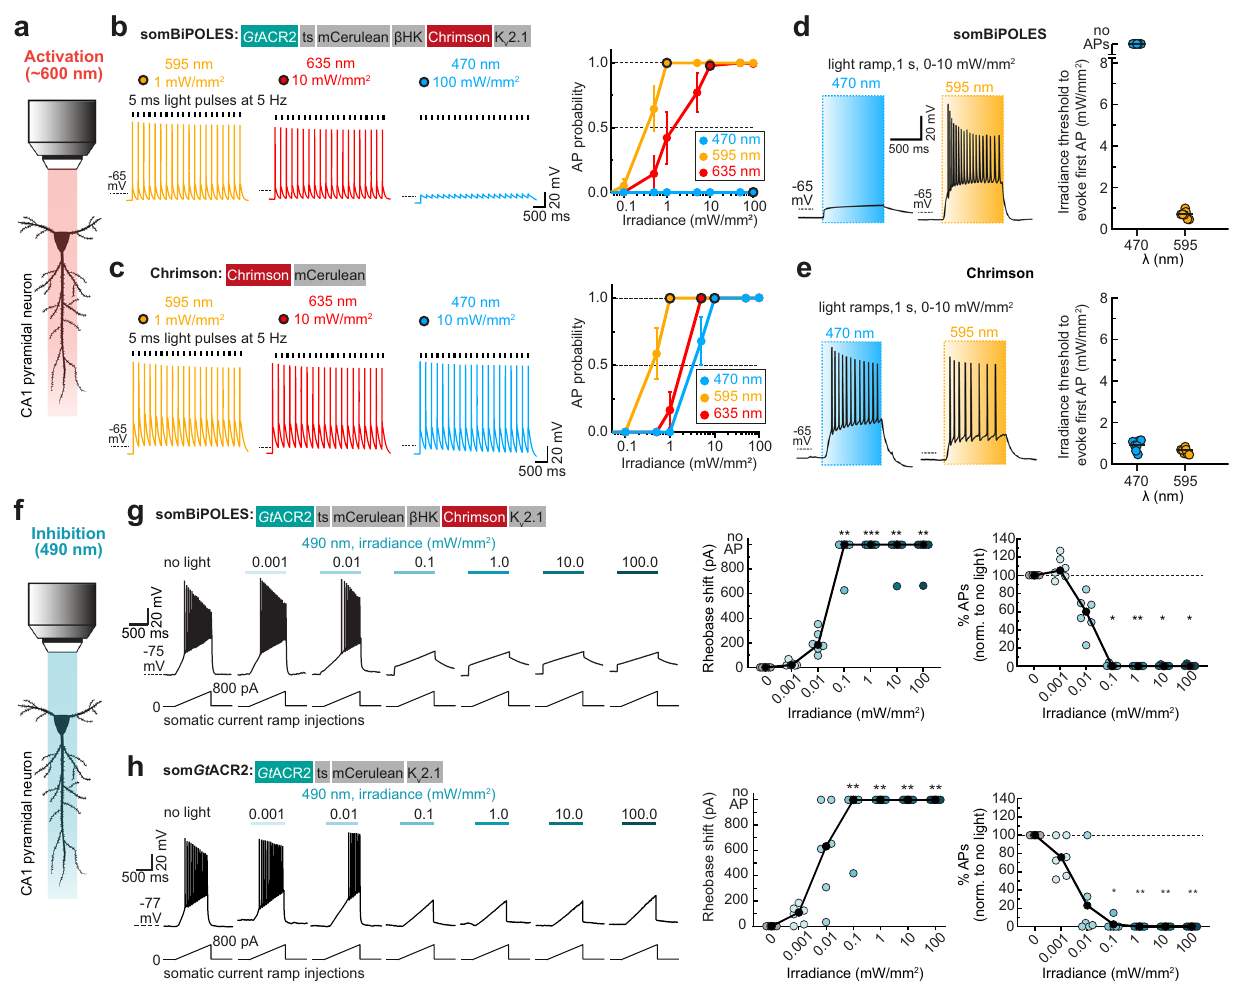
Fig. 3 somBiPOLES allows potent dual-color spiking and silencing of the same neurons using red and blue light, respectively. a Quanti fi cation of neuronal excitation with somBiPOLES or Chrimson only . b Optical excitation is restricted exclusively to the orange/red spectrum in somBiPOLES- expressing neurons. Left: Example traces of current-clamp (IC) recordings in somBiPOLES-expressing CA1 pyramidal cells to determine light-evoked action potential (AP)-probability at different wavelengths. Right: quanti fi cation of light-mediated AP probability at indicated wavelengths and irradiances (symbols correspond to mean ± SEM, n = 8 cells). Black outlined circles correspond to irradiance values shown in example traces on the left. c Same experiment as shown in b , except that CA1 neurons express Chrimson only (symbols correspond to mean ± SEM, n = 7 cells) Note blue-light excitation of Chrimson, but not somBiPOLES cells. d Light-ramp stimulation to determine the AP threshold irradiance. Left: Representative membrane voltage traces measured in somBiPOLES-expressing CA1 pyramidal neurons. The light was ramped linearly from 0 to 10 mWmm − 2 over 1 s. Right: Quanti fi cation of the irradiance threshold at which the fi rst AP was evoked (black horizontal lines: medians, n = 7 cells). e Same experiment as shown in ( b ), except that CA1 neurons express Chrimson only (black horizontal lines: medians, n = 7 cells). The threshold for action potential fi ring with 595 nm was similar between somBiPOLES-expressing and Chrimson-expressing neurons, while somBiPOLES cells were not sensitive to blue light. f Quanti fi cation of neuronal silencing with somBiPOLES or som Gt ACR2 only. g somBiPOLES mediates neuronal silencing upon illumination with blue light. Left: Current ramps (from 0 – 100 to 0 – 900 pA) were injected into somBiPOLES-expressing CA1 pyramidal cells to induce APs during illumination with blue light at indicated intensities (from 0.001 to 100 mW mm − 2 ). The injected current at the time of the fi rst action potential was de fi ned as the rheobase. Right: Quanti fi cation of the rheobase shift and the relative change in the number of ramp-evoked action potentials. Illumination with 490 nm light of increasing intensities activated somBiPOLES-mediated Cl − currents shifting the rheobase to higher values and shunting action potentials. h Same experiment is shown in g , except that CA1 neurons express som Gt ACR2 only. Note similar silencing performance of somBiPOLES and Gt ACR2. In h , g black circles correspond to medians, n somBiPOLES = 6 cells, n som Gt ACR2 = 6 cells, one-way Friedman test, * p < 0.05, ** p < 0.01, *** p <